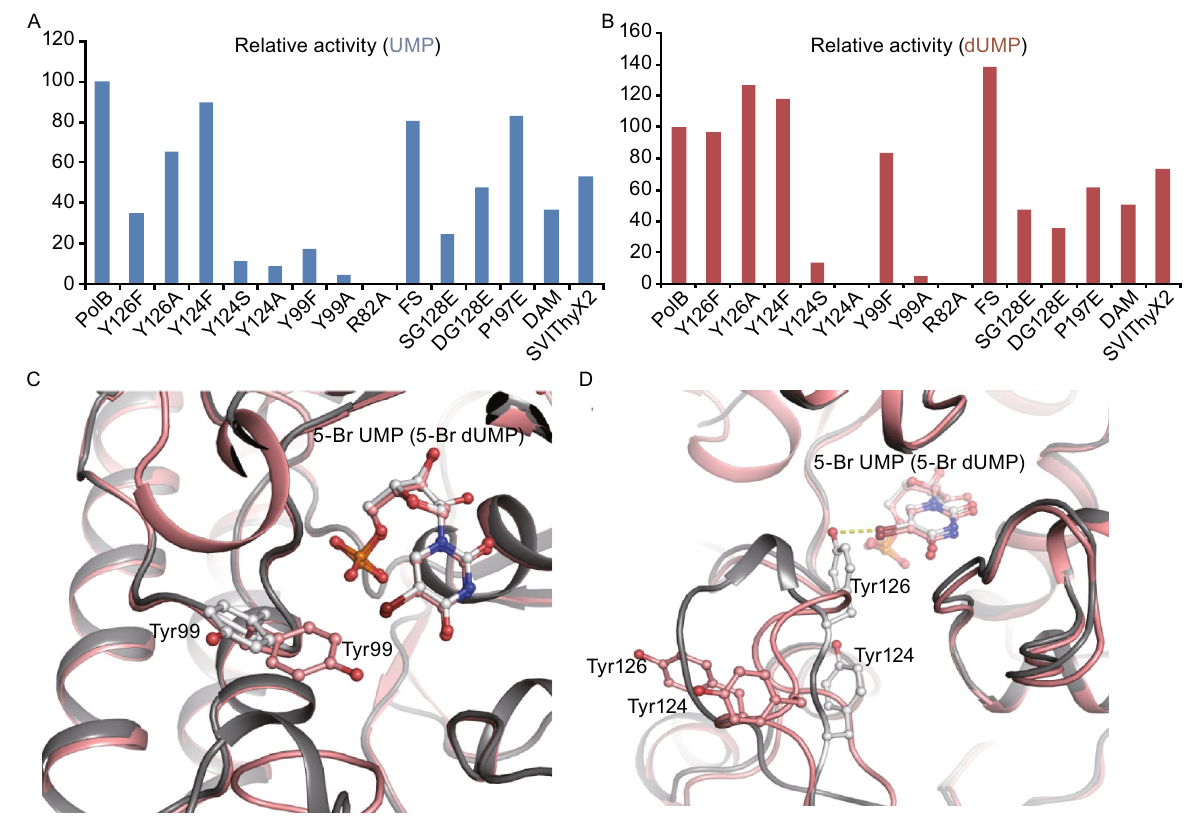
Figure 6. Analysis of the roles of Loop 1 and Loop 2 in PolB catalysis. (A) Comparison of the catalytic activities of PolB and its variants for UMP. (B) Comparison of the catalytic activities of PolB and its variants for dUMP. The relative activity was calculated on the basis of 3 repeats, and the error was all under control of ±5%. (C) Conformational change of Try99 in PolB-5-Br dUMP (salmon) and PolB-5-Br UMP (gray). (D) Conformation change of key residues Tyr124 and Tyr126 in Loop 1 around access while bound with 5-Br UMP (salmon) or 5-Br dUMP